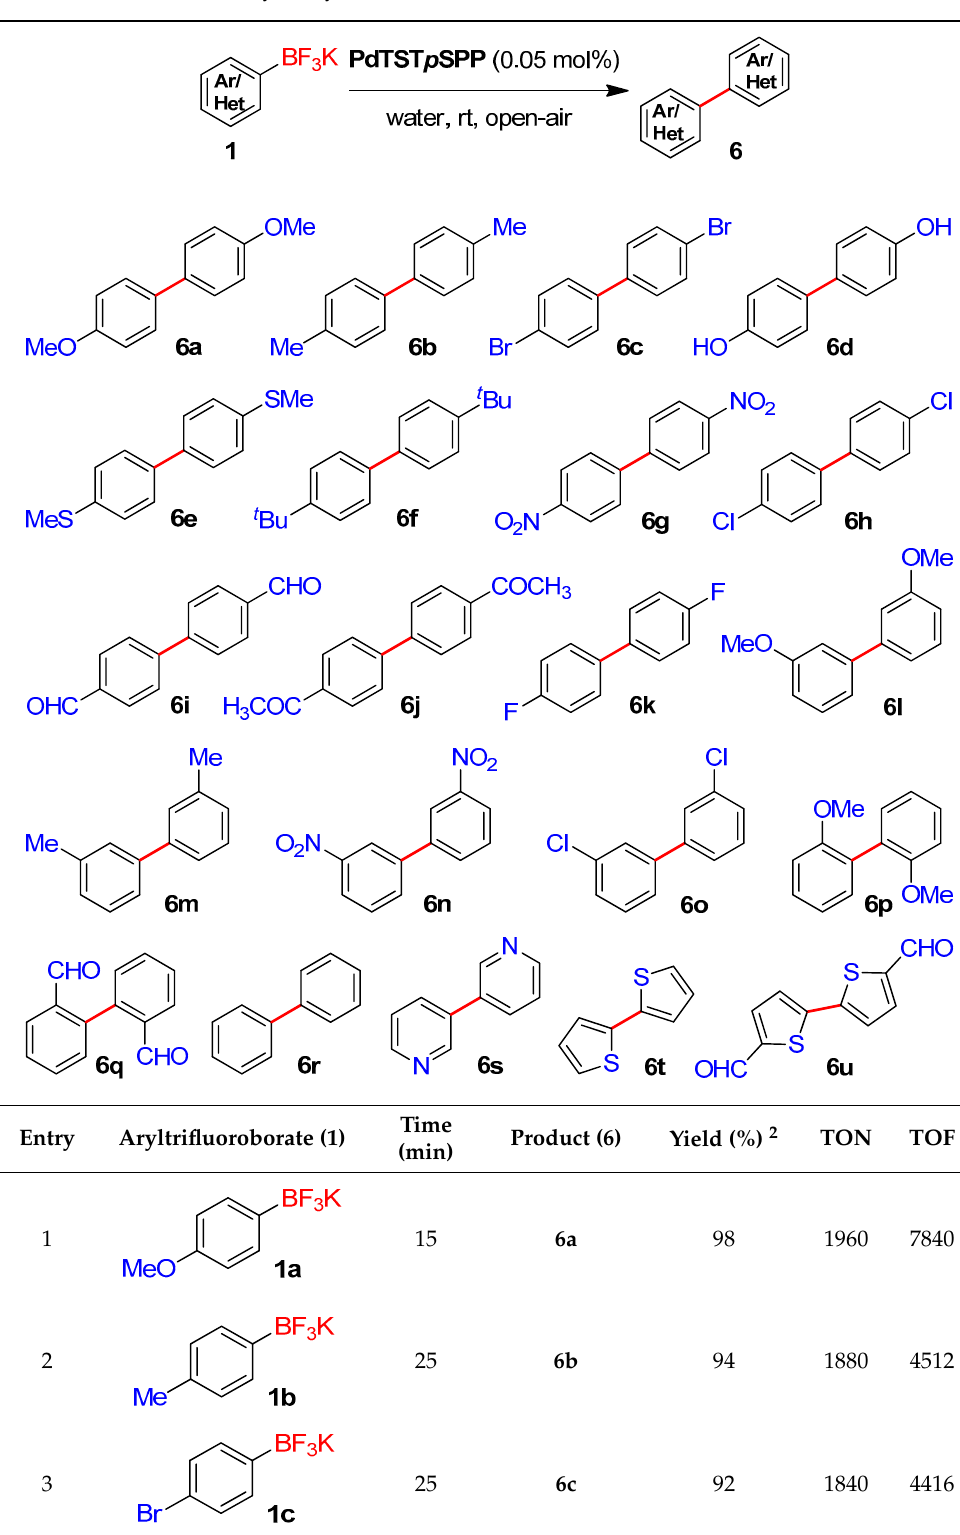
Table 2. Substrate feasibility study 1 .